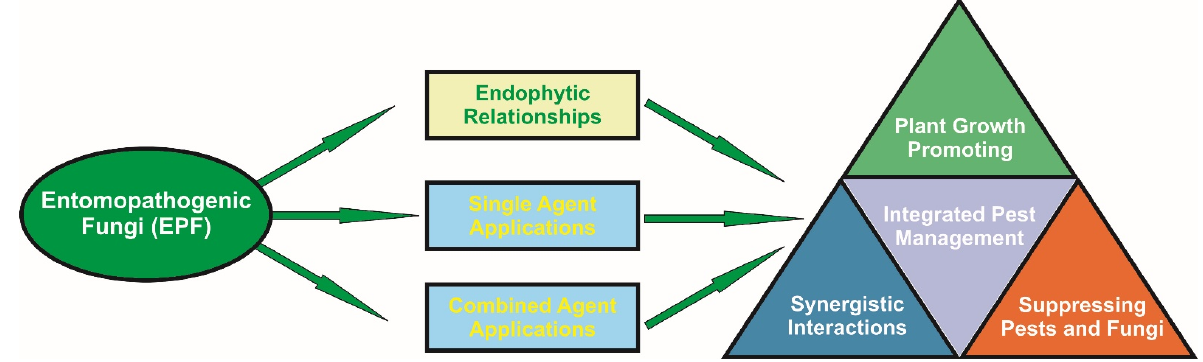
Figure 1. Applications of entomopathogenic fungi and the main effects.